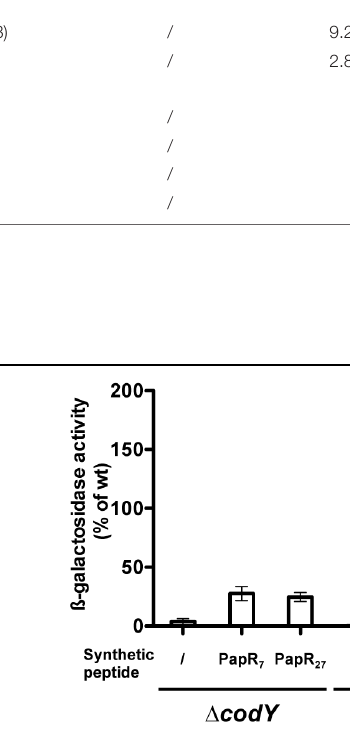
TABLE 3 | PapR-derived peptides detected in wild-type and (cid:2) codY cell culture supernatants. Sequence Best Evalue a m/z (th) b Relative (cid:2) codY Peptides found in both supernatants AWGISLGDTAFEKSQIISHNDQEVQVA